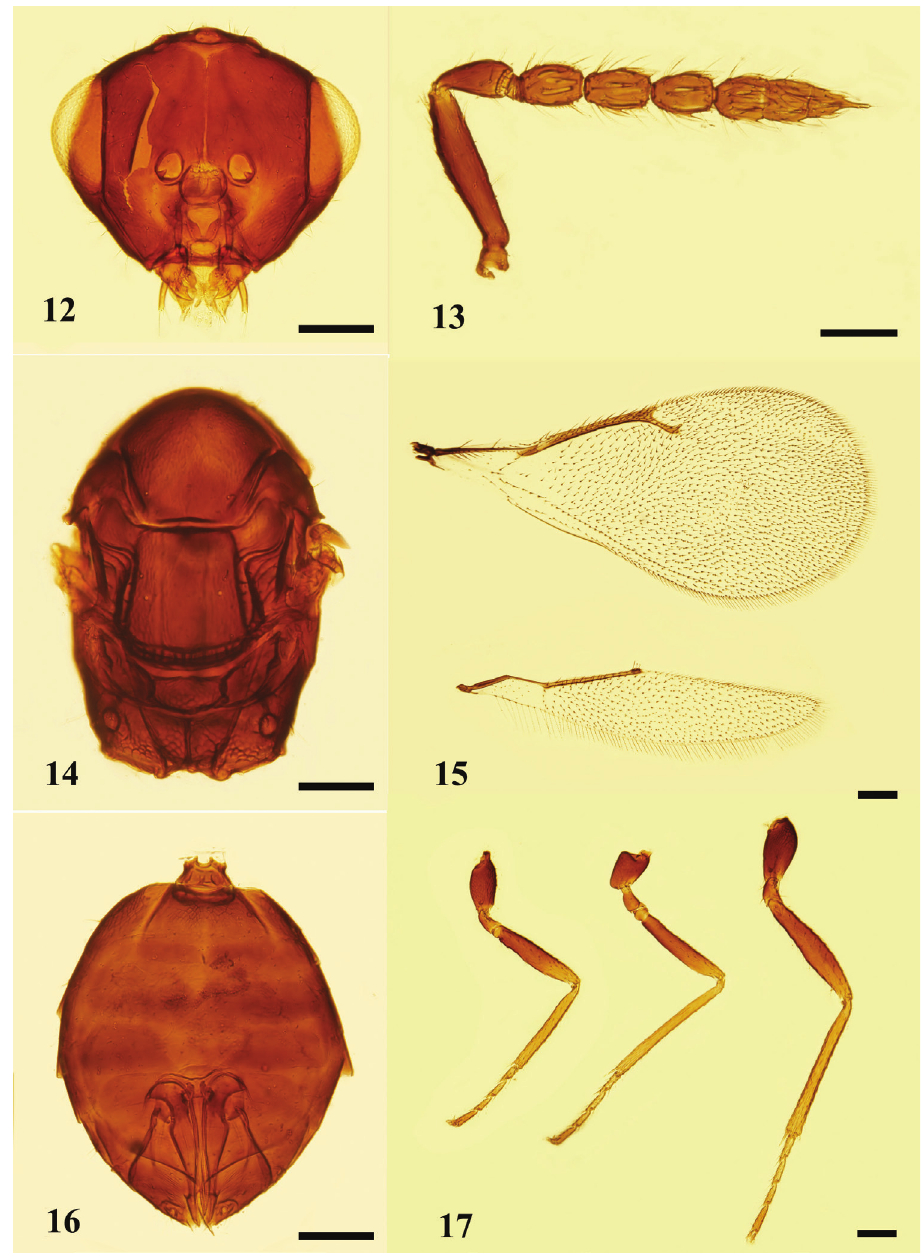
Figures 12–17. Holcotetrastichus rhosaces (Walker), female 12 head, frontal view 13 antenna, lateral view 14 mesosoma, dorsal view 15 fore and hind wings, dorsal view 16 metasoma, ventral view 17 legs, lateral view, from left to right: fore, mid, and hind legs. Scale bars: 100